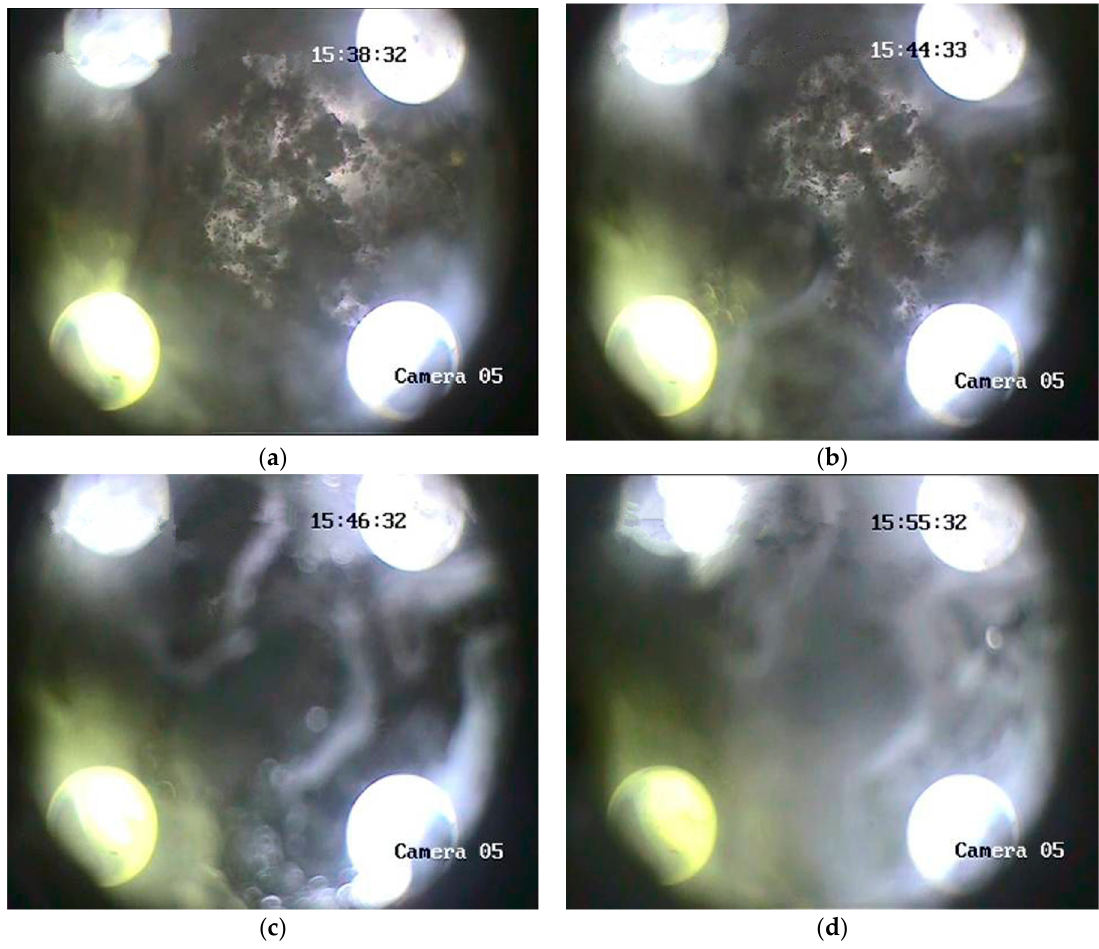
Figure 7. Hydrate formation process in the loop: ( a ) Clear gas-liquid two-phase flow; ( b ) Vague gas-liquid two-phase flow; ( c ) Particle hydrate slurry; ( d ) Cloud hydrate slurry.